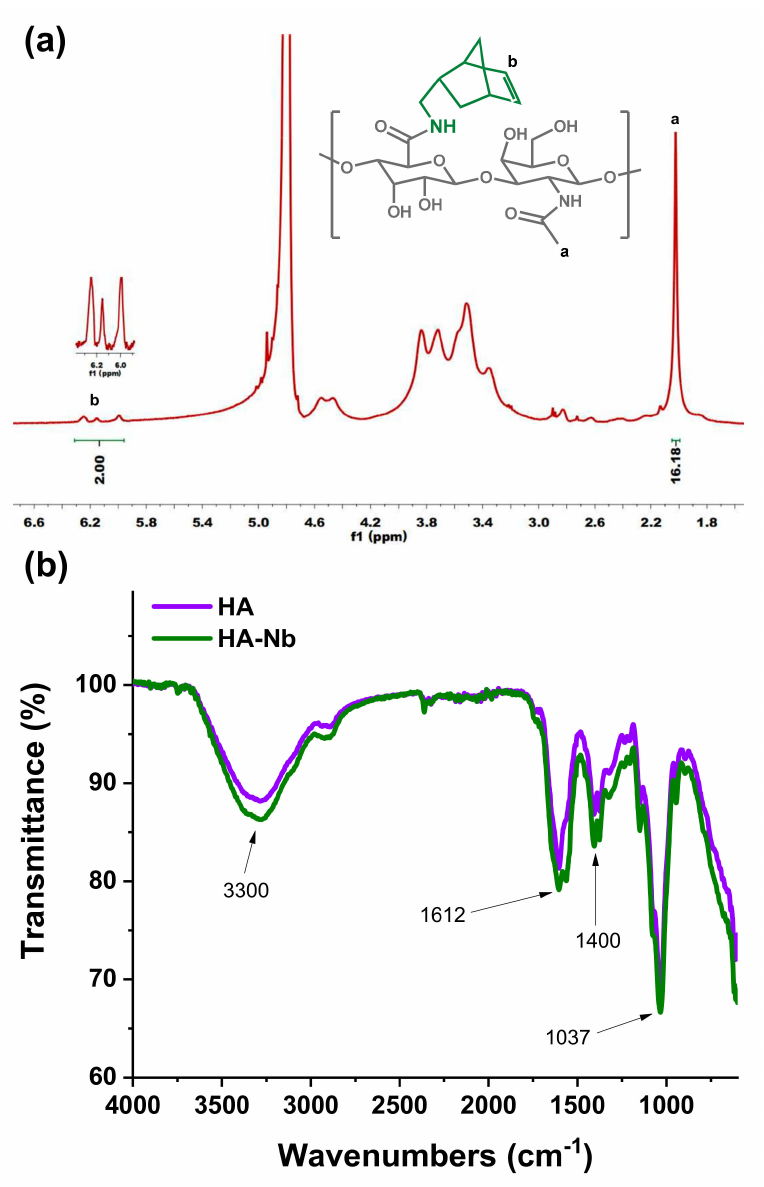
Figure 2. Characterization of HA-Nb. ( a ) 1 H NMR spectrum of HA-Nb and ( b ) FTIR spectrum of HA and